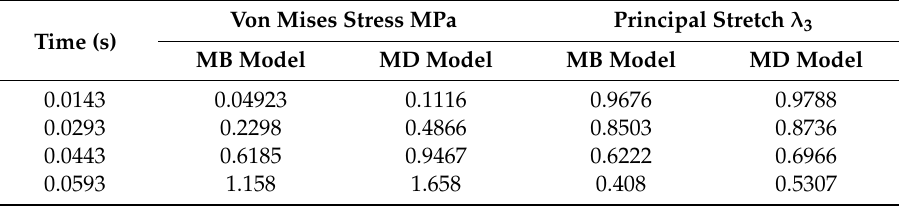
Figure 11. Volume evolution with time of PMSQ–HDPE.